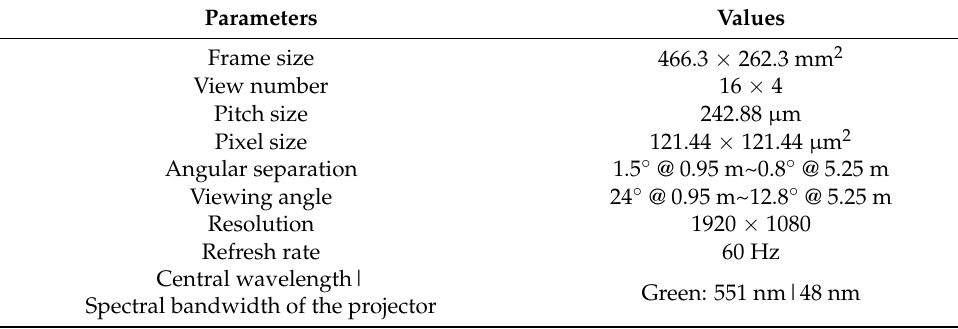
Table 1. Typical parameters of 20-inch AR vector light field display.